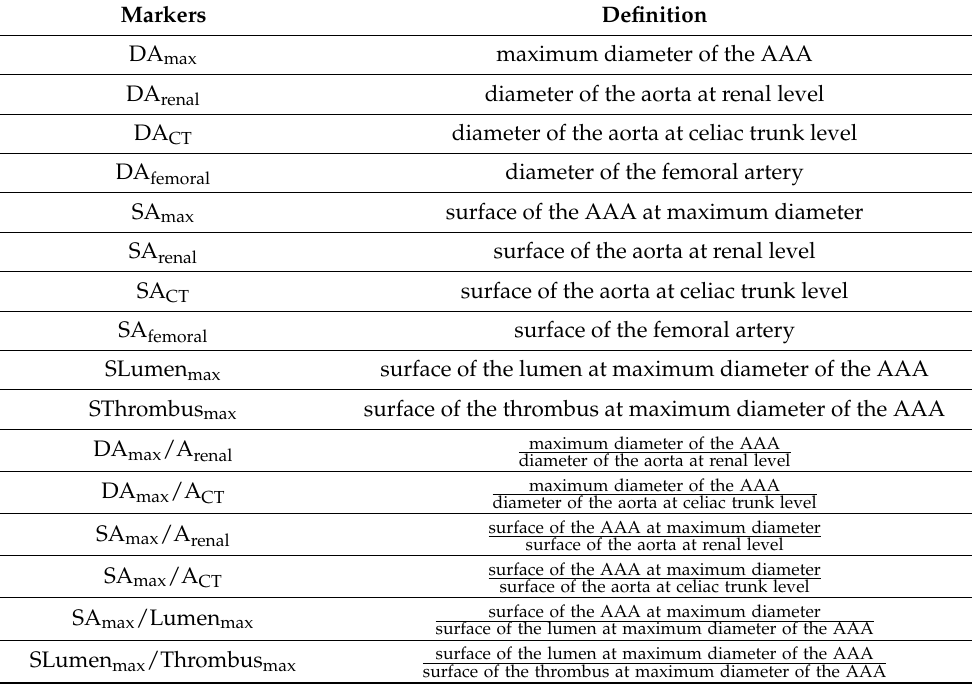
Table 1. Imaging markers